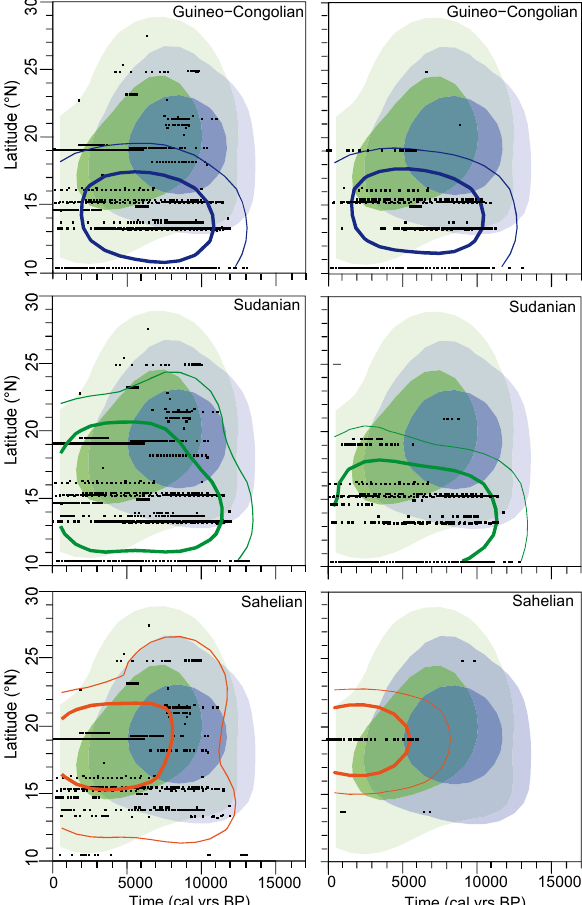
Fig. 2. Spatio–temporal changes (in latitude and millennia) in pollen taxa presences within the Guineo–Congolian, Sudanian, and Sahe- lian groups during the Holocene using probability density functions (Kühl et al., 2002). Left panels give spatio–temporal distributions based on non-exclusive taxa, while right ones give distributions computed with only exclusive taxa. Bold line stands for the 0.5 iso- probability delineating the core zone in which 50% of the samples are the most concentrated (maximum presence). Similarly, the thin line is the 0.85 isoprobability delineating the maximum extent zone in which 85% of the samples are included (Lézine et al., 2011a). Black dots are representative of pollen samples referenced in lat- itude and time. Blue and green probability density functions refer to lacustrine and palustrine distribution through time, respectively, with dark areas reflecting core zones (0.5 isoprobability computed on paleohydrological data), while light areas refer to the maximum extent (from Lézine et al.,